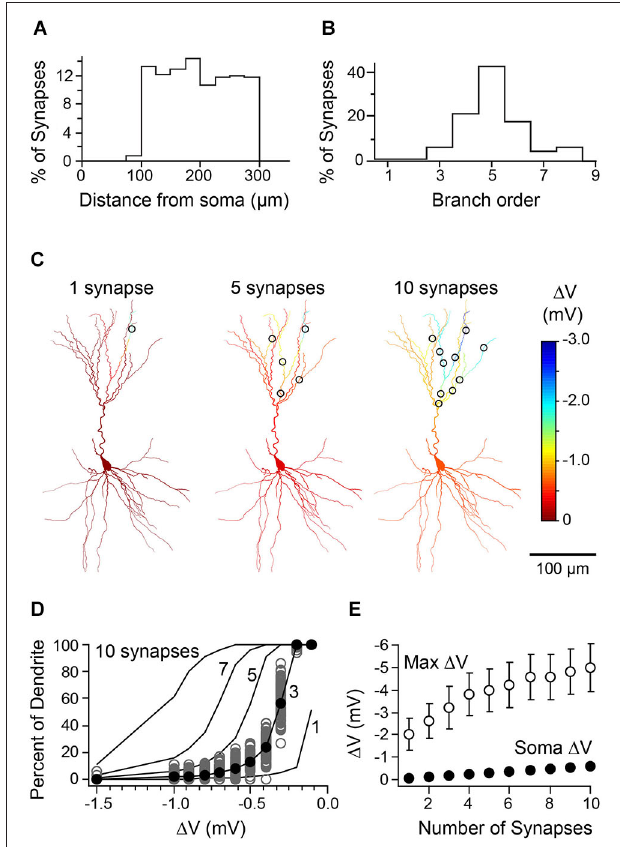
FIGURE 8 | Relationship between number of synaptic contacts of L1 interneuron-L3 PC pairs and distribution of inhibition. (A) Histogram representing the distance from soma for locations of synapses drawn in the model ( n = 100 synapses/cell over 5 cells; compare to histogram in Figure 1C ). (B) Histogram of the branch order for synapses randomly drawn from the uniform distribution represented in Figure 1D . (C) Simulated spatial profile of hyperpolarization from the activation of 1, 5, or 10 randomly placed synapses (same cell as in Figure 1 ). (D) Cumulative distribution curves representing mean dendritic hyperpolarization generated by 1, 3, 5, 7, or 10 synapses placed in the same cell. Gray circles, 100 iterations of 3 synapses distributed over the apical dendrites. Black circles, the mean cumulative distribution of dendritic hyperpolarization (mean of values depicted by gray circles). Black lines, mean curves generated by 100 iterations of the model. (E) Summary data from simulations of five cells showing the mean maximal dendritic voltage change (open circles) and somatic voltage change (closed circles) as a function of the number of synapses activated (error bars are <